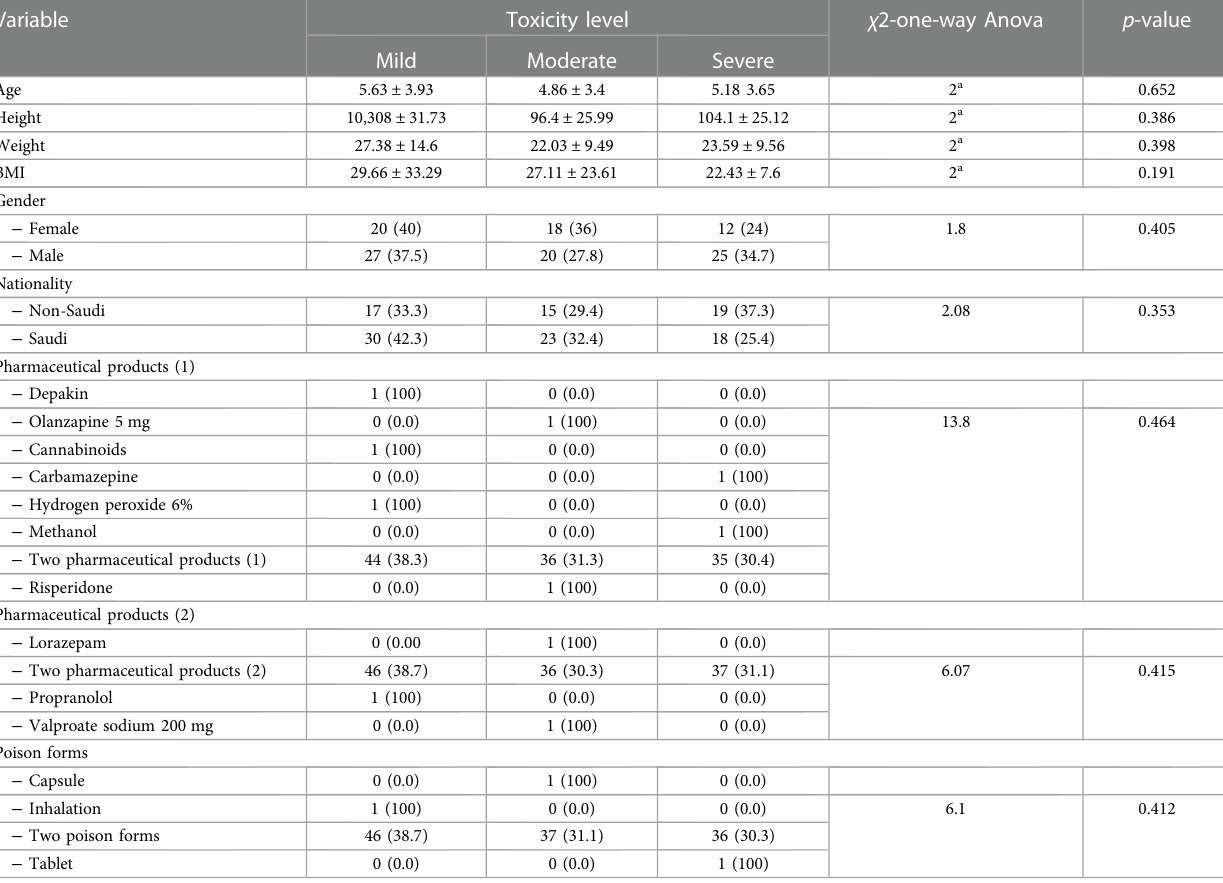
TABLE 5 Relationship between level of the toxicity and the children ’ s characters, weight, BMI. pharmaceutical products and poison forms ( n =122).